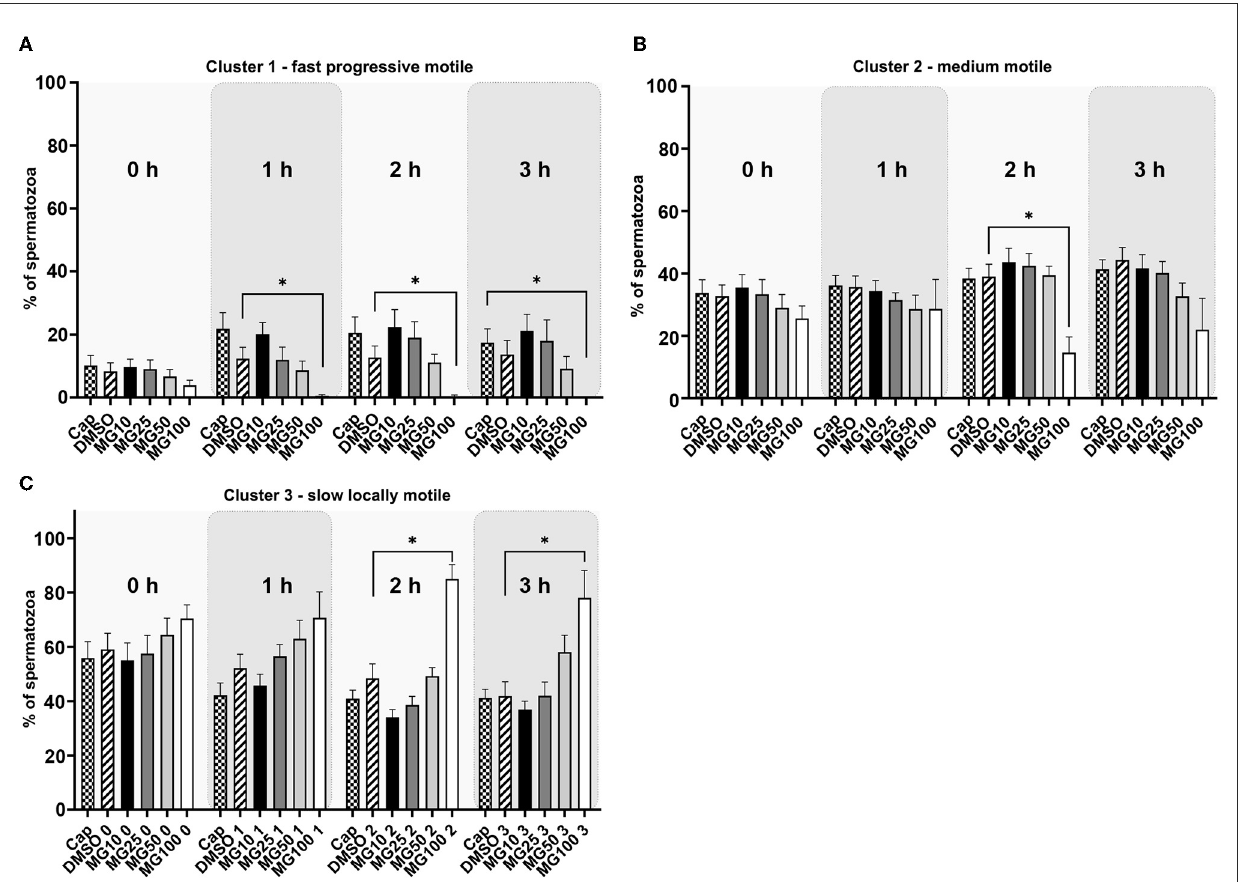
FIGURE2 K-means cluster analysis evaluation of sperm motility based on the cluster distribution throughout all kinematic parameters during sperm in vitro capacitation with MG-132 proteasomal inhibition (10, 25, 50, and 100 µ M) including capacitating (Cap) and vehicle (DMSO) controls. Data are presented as mean ± SEM. Significance levels * p ≤ 0.05. (A) Cluster 1 with rapid progressively motile spermatozoa, (B) Cluster 2 with medium level progressive motile spermatozoa, (C) Cluster 3 with low motile, static